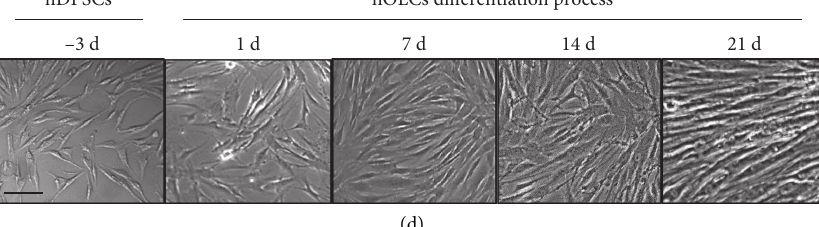
Figure 1: Phenotypic characterization of hDPSCs and morphological cell appearance during the cell differentiation process. (a) The PDT was calculated considering the cell count performed in the first 96 hours (4 days) of cell culture, using a hemocytometer. Results are shown as the average of three independent experiments in triplicate ( n � 9). (b) The undifferentiated mesenchymal phenotype was verified using flow cytometry by using the cocktail for phenotyping of Miltenyi, which demonstrated positivity for mesenchymal markers CD90, CD105, and CD73 and negativity for the early hematopoietic markers CD14, CD20, CD34, and CD45. A total of 100,000 events were acquired with the use of the FACSCalibur cytometer, and the data were analyzed using FCS Express software. (c) To evaluate the differentiation potential of hDPSCs, they were exposed to differentiation media for the three lineages for 21 days and the respective stains were performed in order to corroborate the acquired phenotype. The osteoblasts were stained with alizarin red, and the formation of mineralization nodules is evidenced. The chondrocytes were stained with Alcian blue, positive labeling of proteoglycans is evidenced, and adipocytes were stained with OilO red; a positive staining of fatty acids is shown. Scale bar:100 μ m. (d) Phase contrast microscopy images showing hDPSCs with tapered, fibroblastic morphology, as well as hOLCs cells during the differentiation process at 7, 14, and 21 days. A trend toward organized training in parallel lines is shown. Leica DM2500 Microscope (Leica Microsystems; Wetzlar, Germany) was used. Scale bar: 100 μ m.